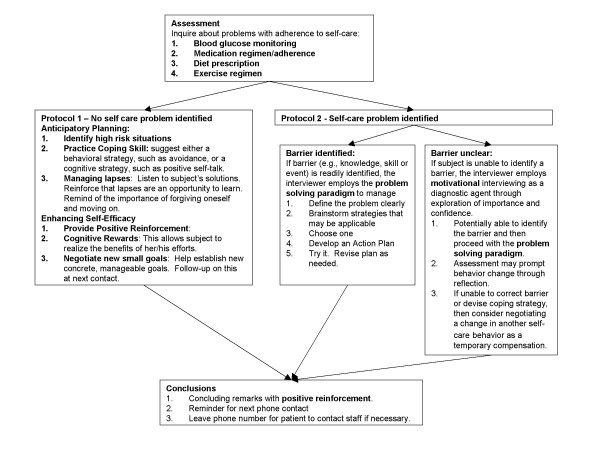
Telephone Contact Intervention Flow Sheet.